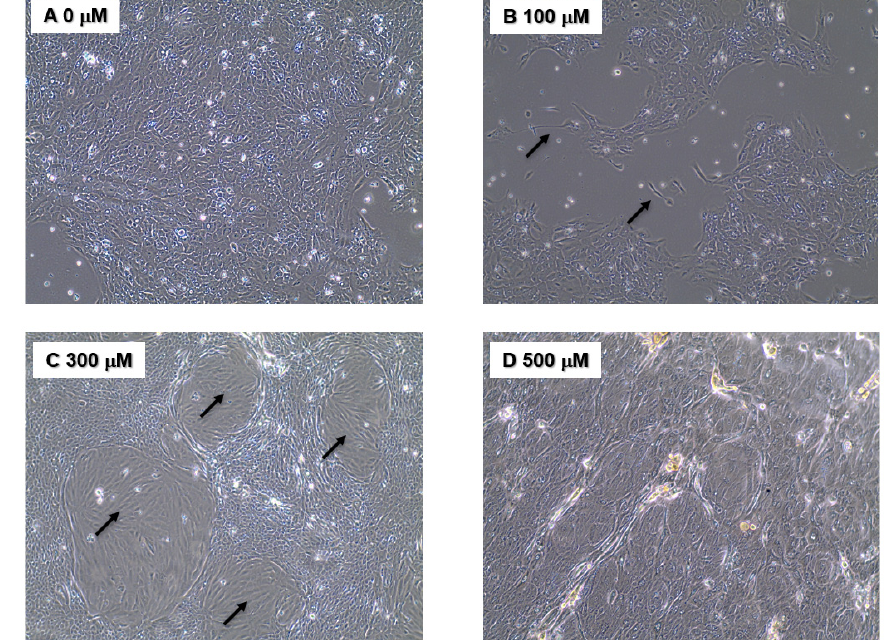
Figure 1. Morphological changes observed in MCF10A cells after prolonged, chronic exposure to NO containing. MCF10A cells were plated at a density of 4 × 10 5 per 60 mm dish and were treated with 0 ( A ), 100 ( B ), 300 ( C ), or 500 ( D ) μ M DETANO twice weekly for three weeks, and then the DETANO was removed, and the cells were analyzed. Elongated cells (black arrow) were observed in NO treated cells.